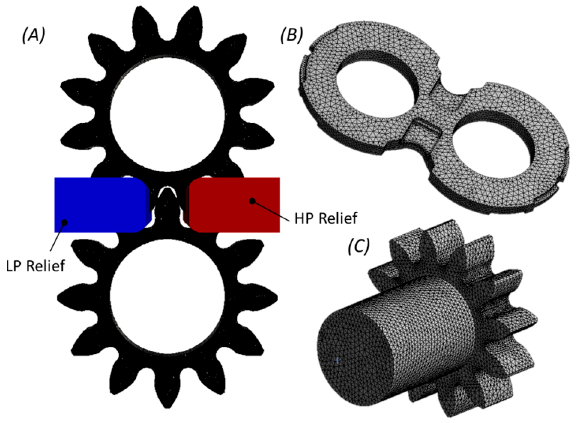
Figure 4. Representation of the various meshes used in the study ( A ) Fluid mesh along with the relief grooves (~120,000 cells); ( B ) Lateral bushing mesh (~40,000 cells); ( C ) Gears mesh (~50,000 cells).